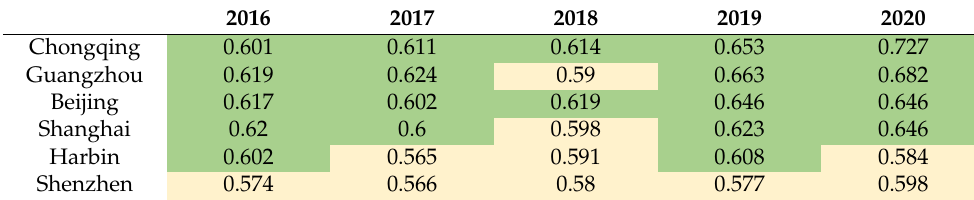
Table A2. Coupling coordination degree among B-T in 36 cities in China.